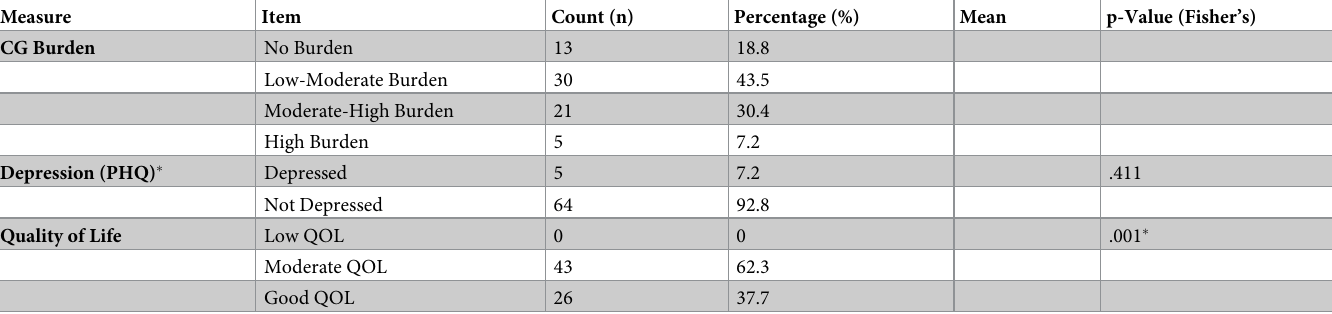
Table 2. Level of caregiver burden, depression, quality of life and correlation with caregiver